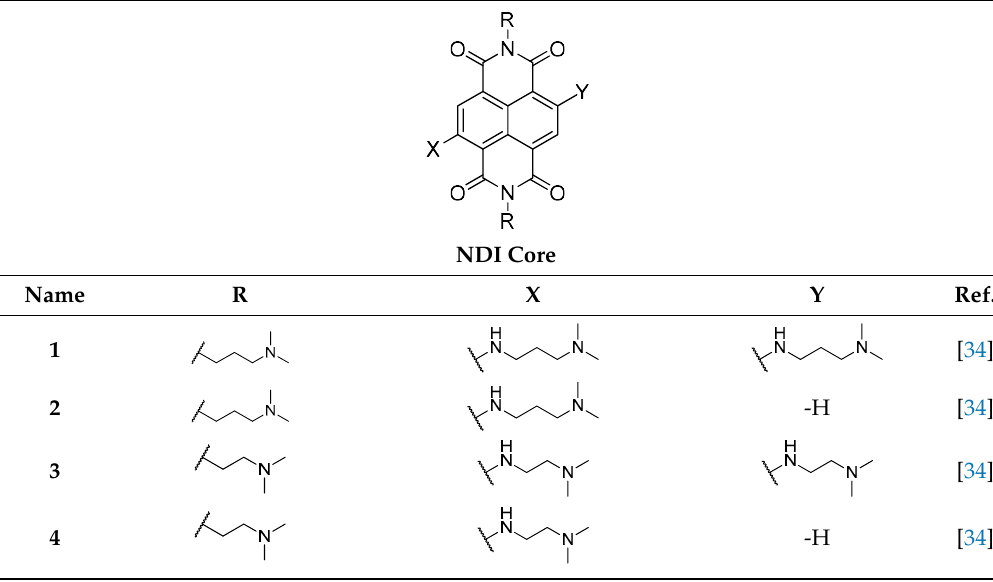
Table 1. Structures of NDIs used as reversible ligands to stabilize telomeric G4s.